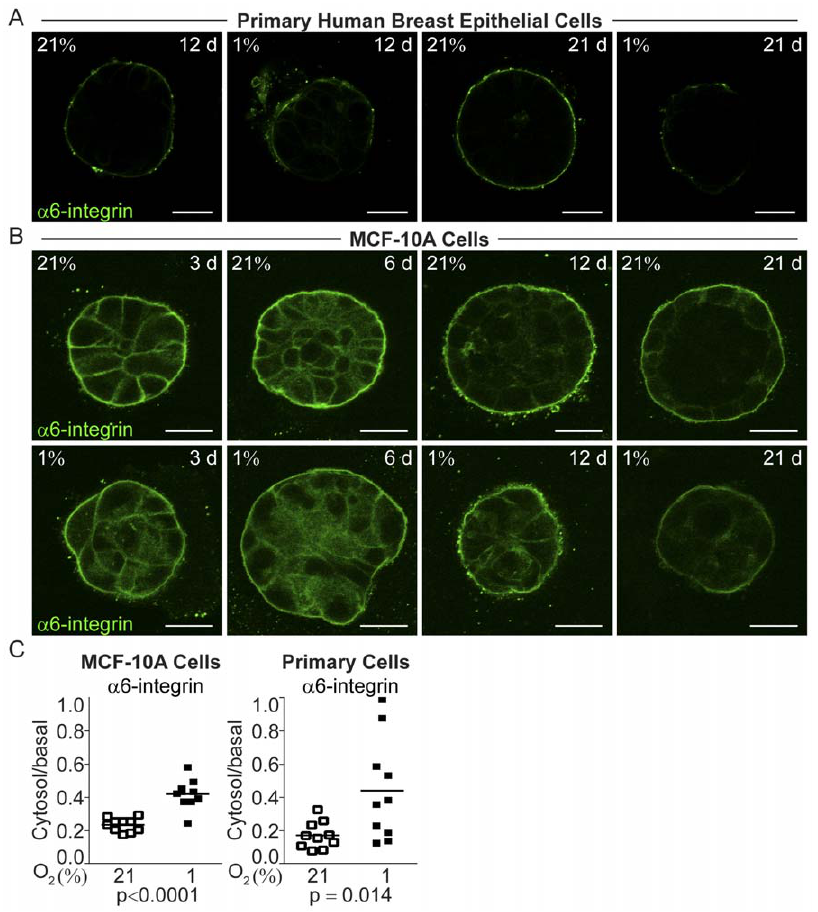
Figure 3. Functional and structural polarization of the human breast epithelial acini-like structures cultured at 21% and 1% oxygen on ECM-derived substrate illustrated by the marker of breast epithelial polarization, a 6-integrin. A. Immunofluorescence staining of the polarization marker a 6-integrin (green) after 12 and 21 days of culture of primary human breast epithelial cells on ECM-derived substrate under normoxic (21%) or hypoxic (1%) conditions. Images from one representative of three independent experiments with cells from different women are shown. Size bars 20 m m. B. a 6-integrin (green) staining of normoxic (21%) and hypoxic (1%) MCF-10A cells in 3D-culture at 3, 6, 12, and 21 days post- seeding on ECM-derived substrate. All confocal micrographs were acquired at the Z-plane where the depictured acini-like structure had the widest circumference. Size bars 20 m m. C. The ratio of intra cellular to basal cell membrane mean fluorophore intensity in normoxic (open) and hypoxic (black) MCF-10A cell- (left panel) and primary human breast epithelial cell organoids (right panel) at 21 days post-seeding, measured in one representative cell in ten different acini-like structures. Statistical analysis was performed with Student’s t-test (p).